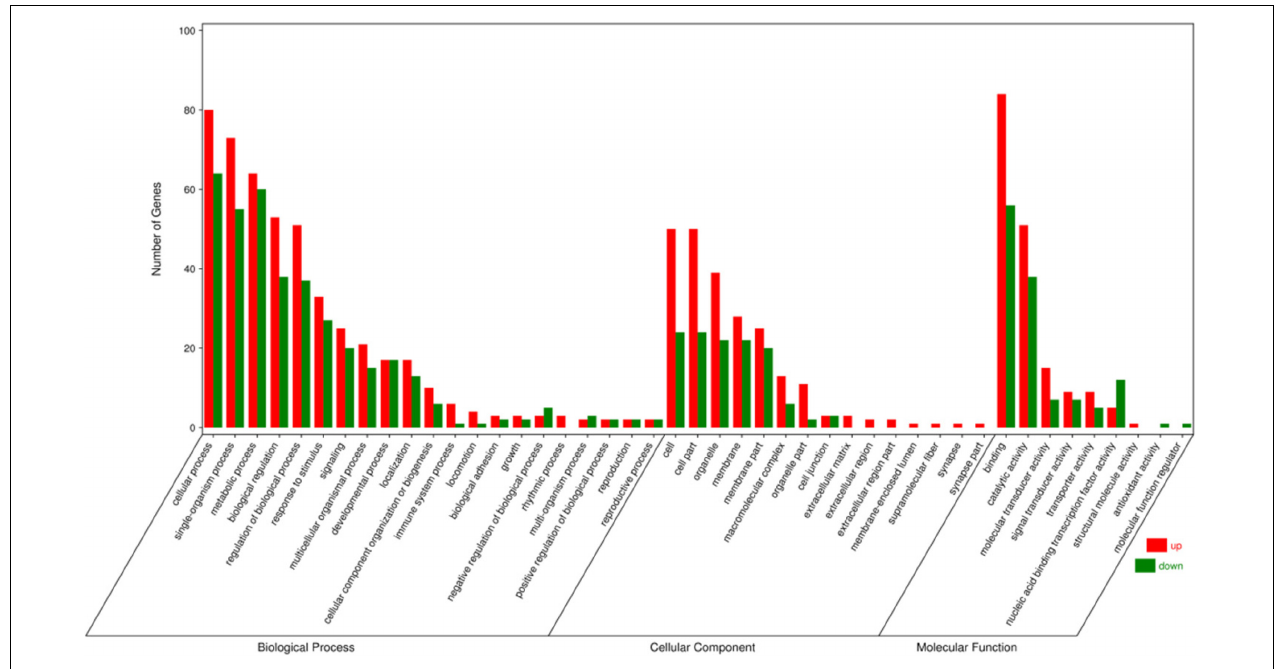
FIGURE 2 | Gene ontology annotations of the differentially expressed unigenes.